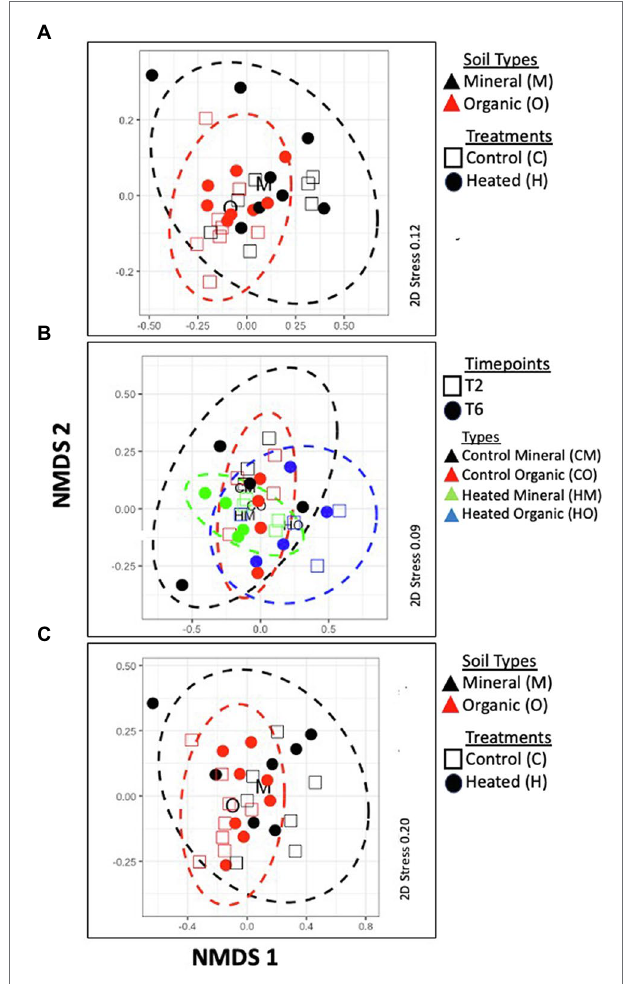
FIGURE 1 | Non-metric multidimensional scaling (nMDS) of the RNA-Seq data – (A) based on KEGG transcripts; (B) CAZy transcripts and (C) Phyla abundances. KEGG and Phyla abundances are clustered by soil types [organic (O) vs. mineral (M)] and treatments [Heated (H) vs. Control (C); KEGG and Phyla] and CAZy transcripts are clustered by soil types, treatments, and time points (T2 and T6). Correlations with grouped samples were calculated by a three-factor multivariate PERMANOVA analyses based on Bray-Curtis similarity that revealed significant differences between soil types (organic vs. mineral) but no differences between time points (T2 vs. T6) or treatments (heated vs. control) in all three